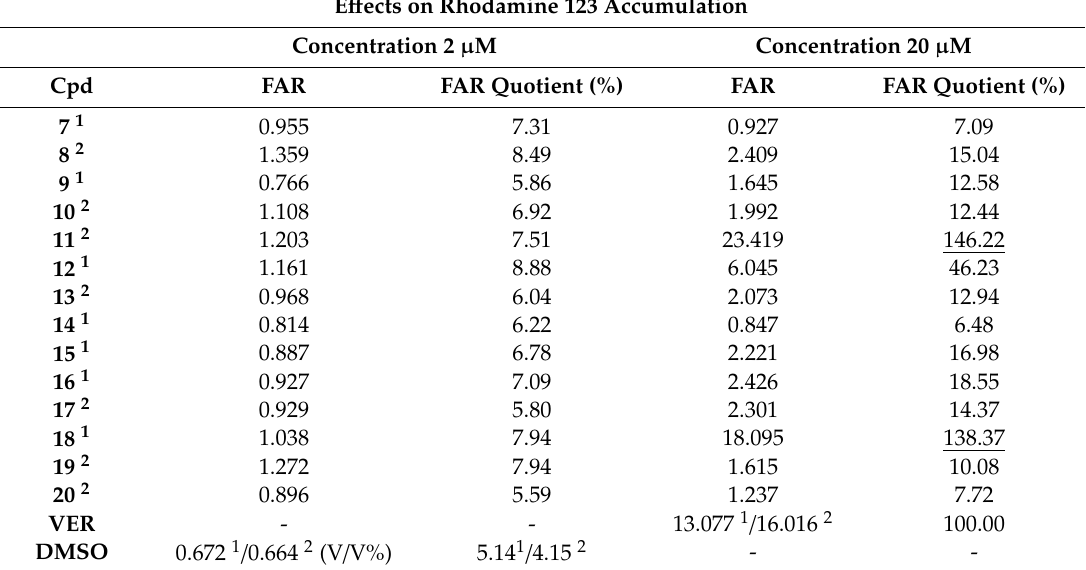
Table 2. E ff ects of 5-arylideneimidazolones ( 7 – 20 ) on rhodamine 123 accumulation by multidrug -resistant (MDR) mouse T-lymphoma